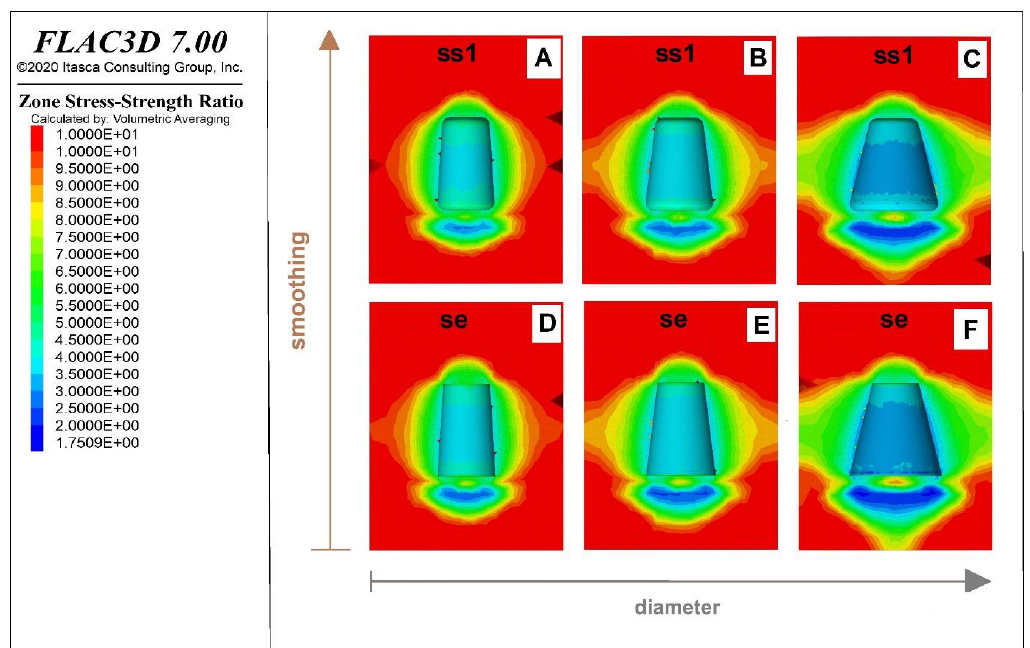
Figure 17. The SSR in enlarged-bottom caverns; the last withdrawal period: ( A,D ) maximum initial diameter of 75 m, ( B,E ) maximum initial diameter of 90 m, ( C,F ) maximum initial diameter of 120 m.